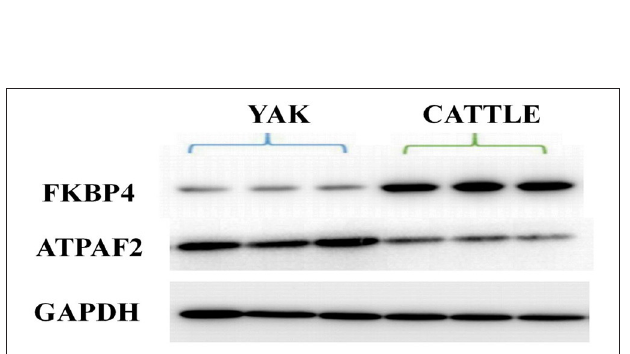
FIGURE 5 | Western blot of FKBP4 and